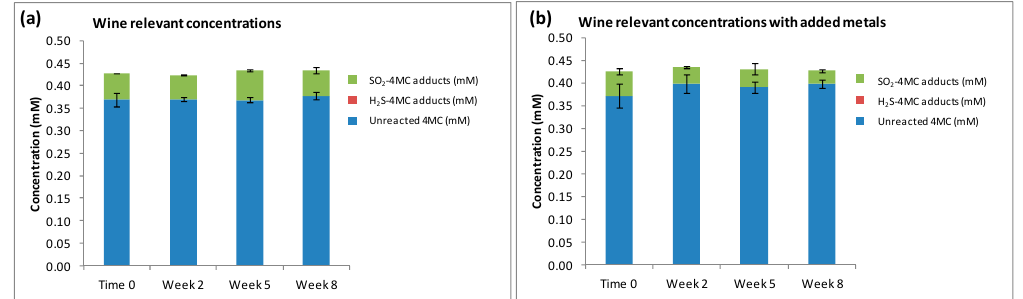
Figure 4. The reaction products measured when 4MBQ (0.45 mM) was added to model wine containing: ( a ) wine relevant concentrations of H 2 S (0.39 µ M) and SO 2 (0.23 mM); and ( b ) wine relevant concentrations of H 2 S (0.39 µ M), SO 2 (0.23 mM), as well as Cu 2+ (0.5 mg/L) and Fe 3+ (4.0